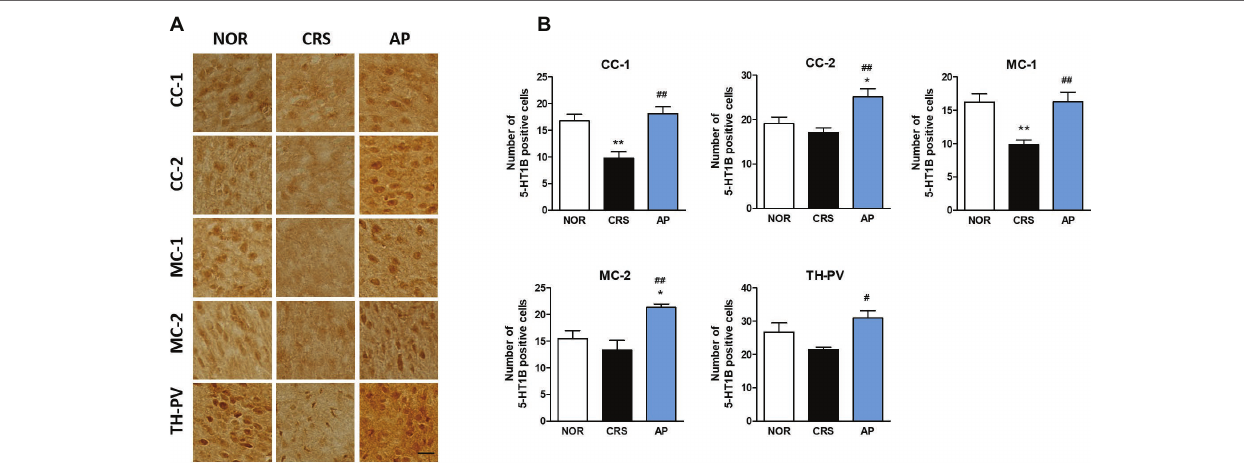
FIGURE 7 | Acupuncture treatment at AP (KI10·LR8·LU8·LR4) changes 5-HT1B receptor expression in the cortex, hippocampus, thalamus, and hypothalamus. (A,B) Acupuncture treatment at AP (KI10·LR8·LU8·LR4) significantly increased 5-HT1B receptor expression in the cortex and thalamus as compared to the CRS group. NOR, normal; AP, CRS and acupuncture treatment at KI10·LR8·LU8·LR4; NP, CRS and acupuncture treatment at non-acupoints on the hips. * p < 0.05, ** p < 0.01 vs. NOR. # p < 0.05, ## p < 0.01 vs. CRS. One-way ANOVA followed by the Newman-Keuls test. Error bars indicate